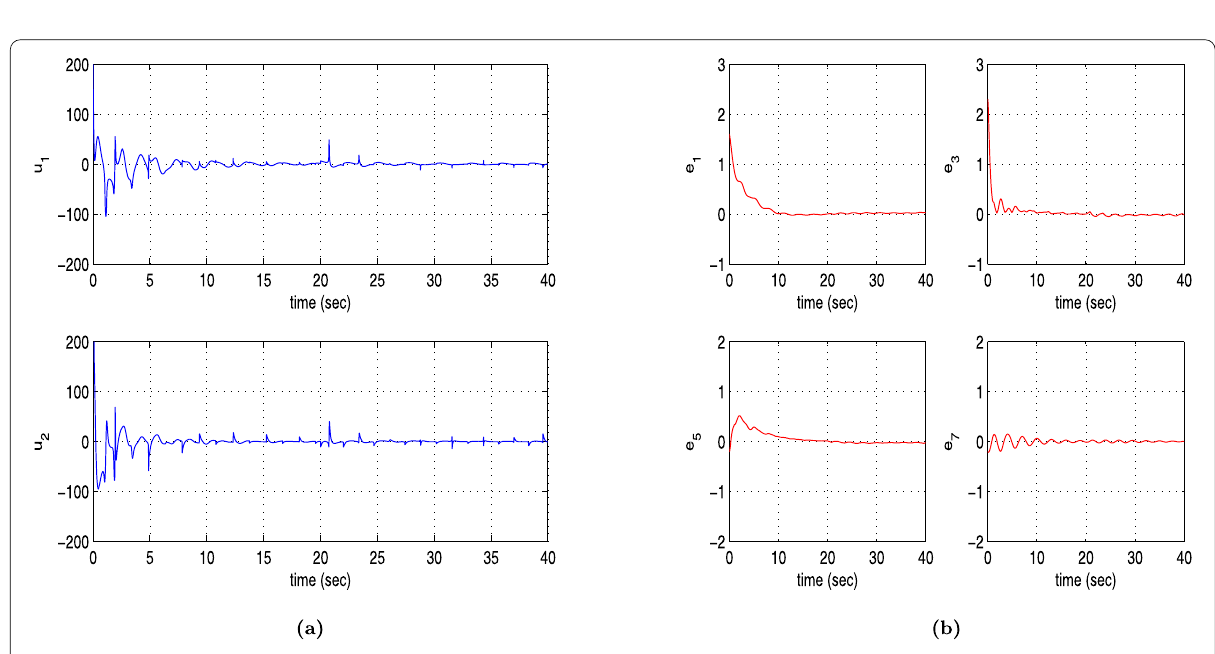
In contrast to PID control the proposed nonlinear opti- mal control method is globally stable and functions well at changes of operating points, (iv) In contrast to multi- models based control and linearization around